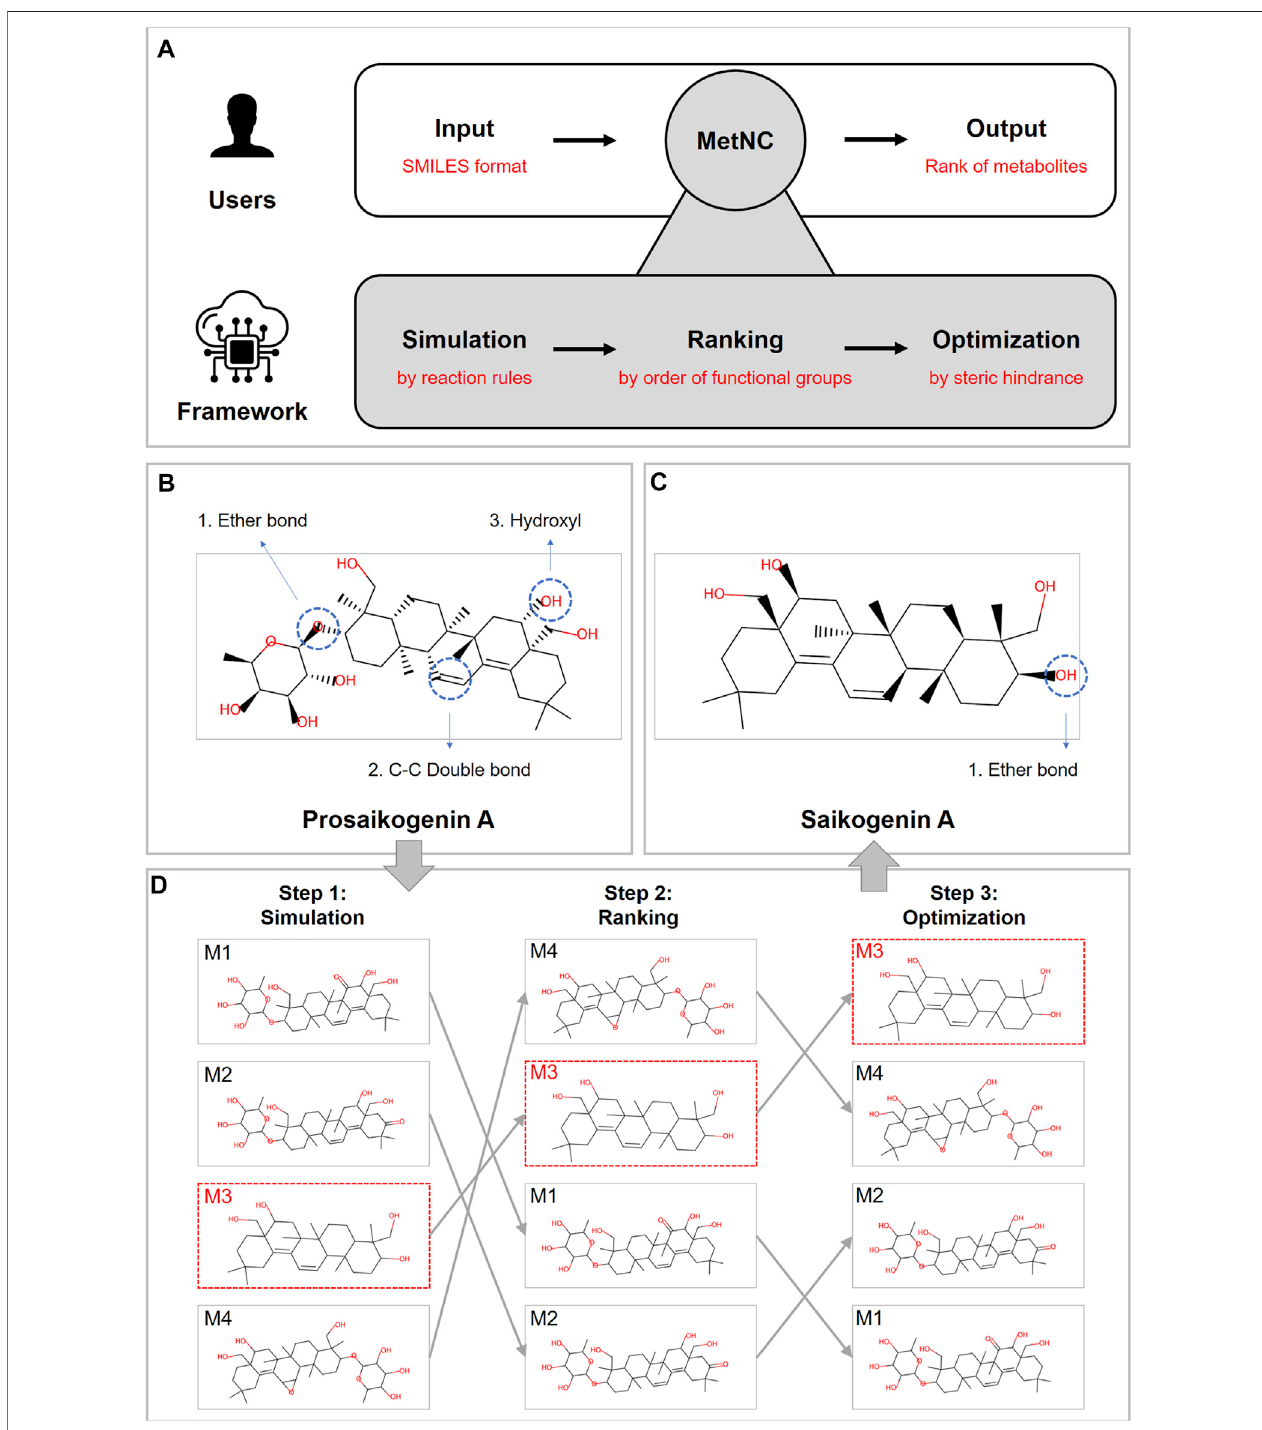
FIGURE1|(A) DesignprinciplesofMetNC. (B) Structure informationofprosaikogeninA. (C) Structure informationofsaikogeninA. (D) MetNCcomputational fl ow of prosaikogenin A to predict saikogenin A.